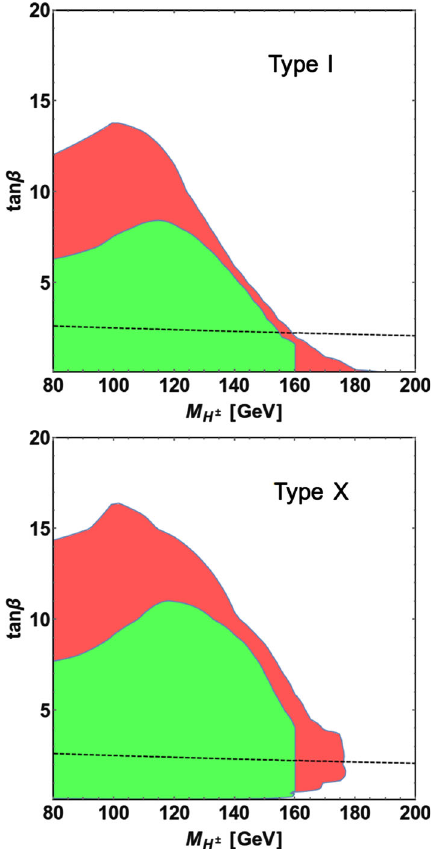
Fig. 3 Exclusion region in Type I and Type X from the upper limits on σ H ± BR ( H ± → τ ± ν) CMS 13 TeV observations are shown in red color. The green color shows the exclusion region from the upper limits on BR ( t → H + b ) BR( H ± → τ ± ν ) CMS 8 TeV observations. The region below the black dashed line is excluded by the BR( B → X s γ )